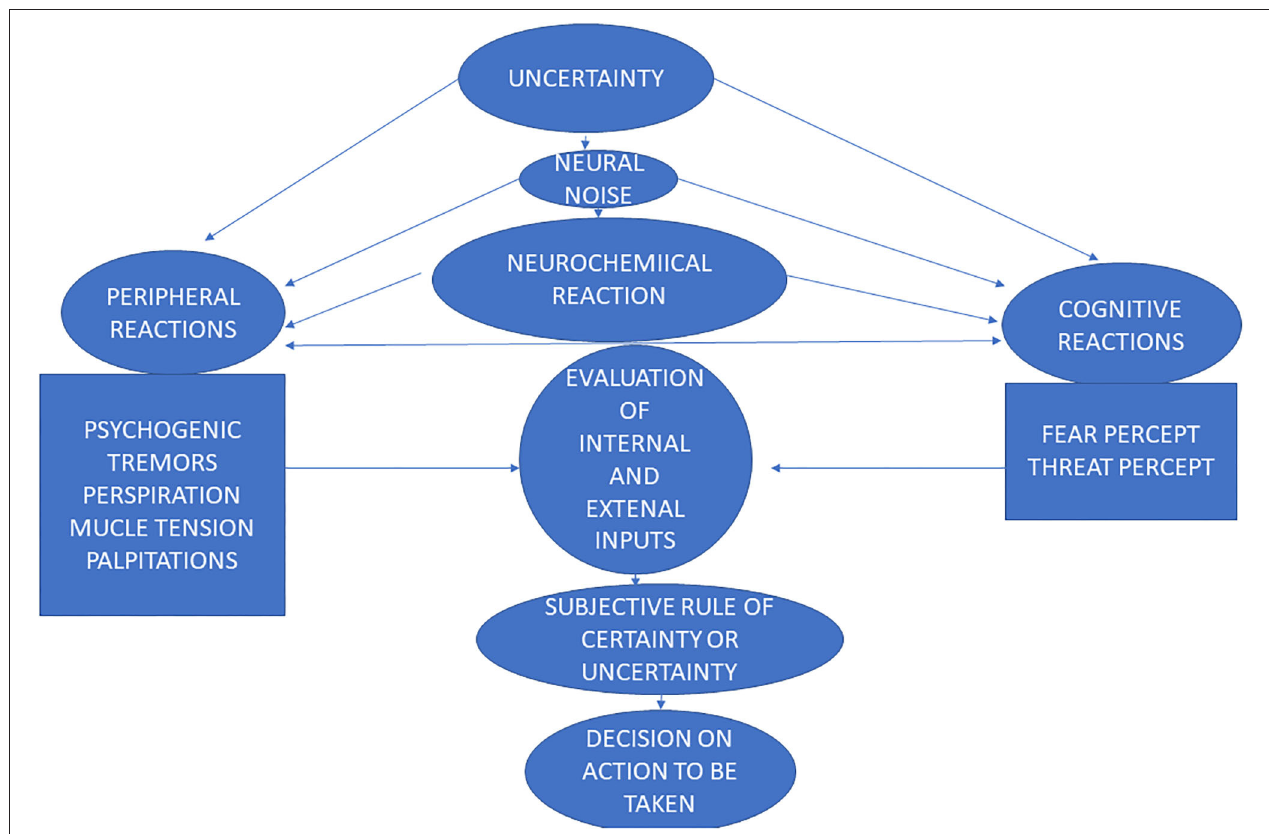
FIGURE 1 | The process of uncertainty from the stage of sensory input to the stage of making a decision on an action to be taken, in anxiety